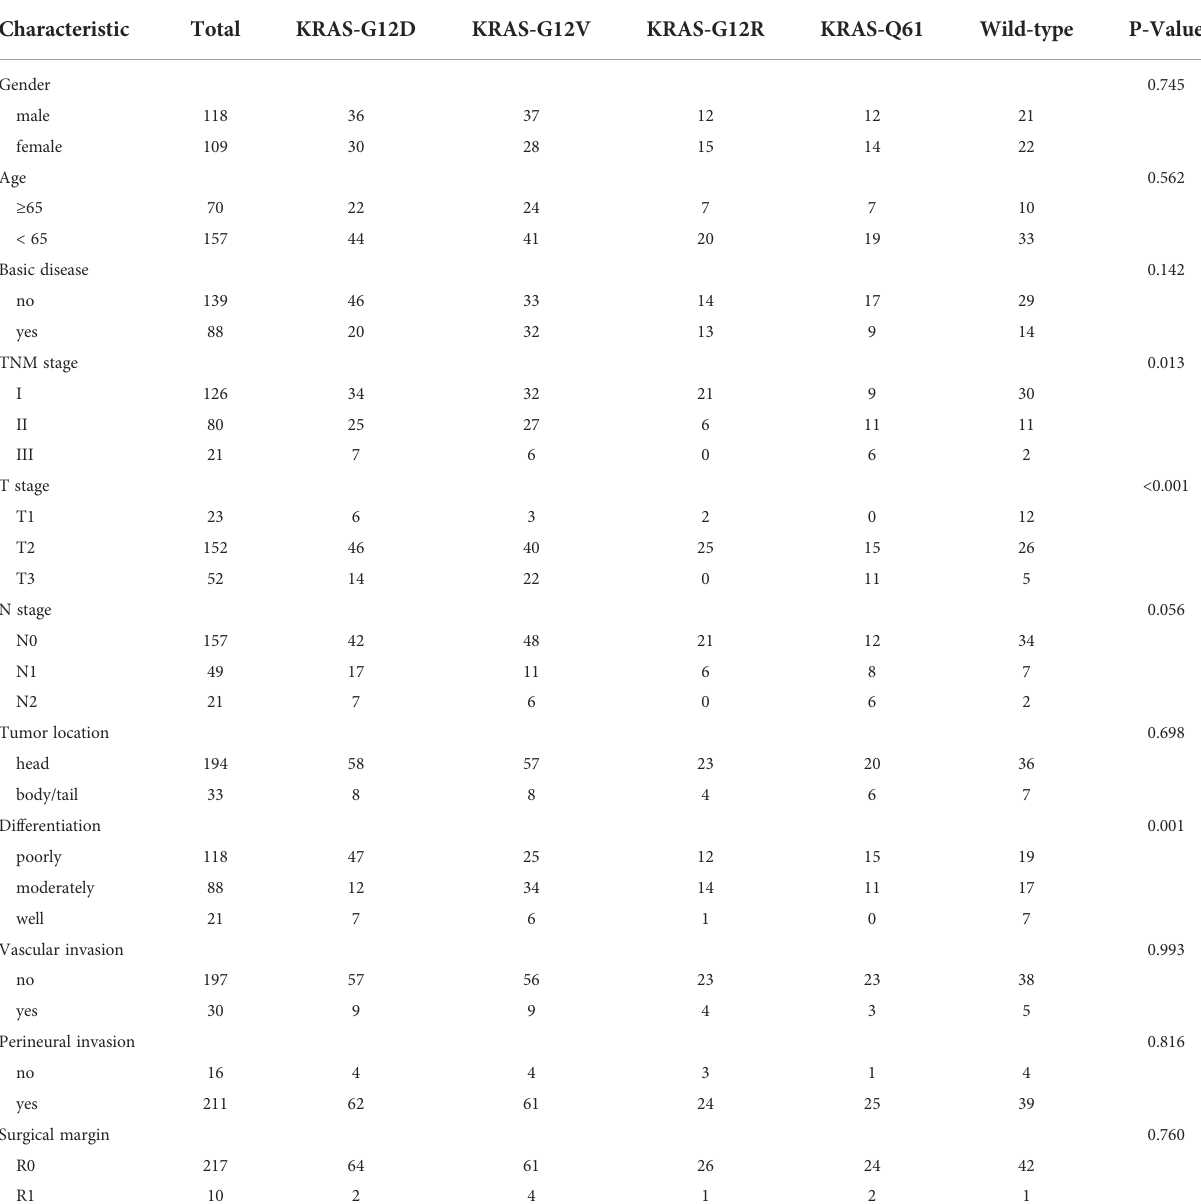
TABLE 1 Main characteristics of the patients.